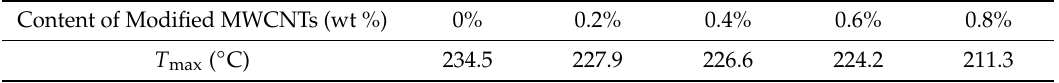
Figure 6. The temporal distribution of temperature of PABA-modified MWCNTs / epoxy reaction system with different modified MWCNTs contents. Table 3. T max of PABA-modified MWCNTs / epoxy resin mixture.